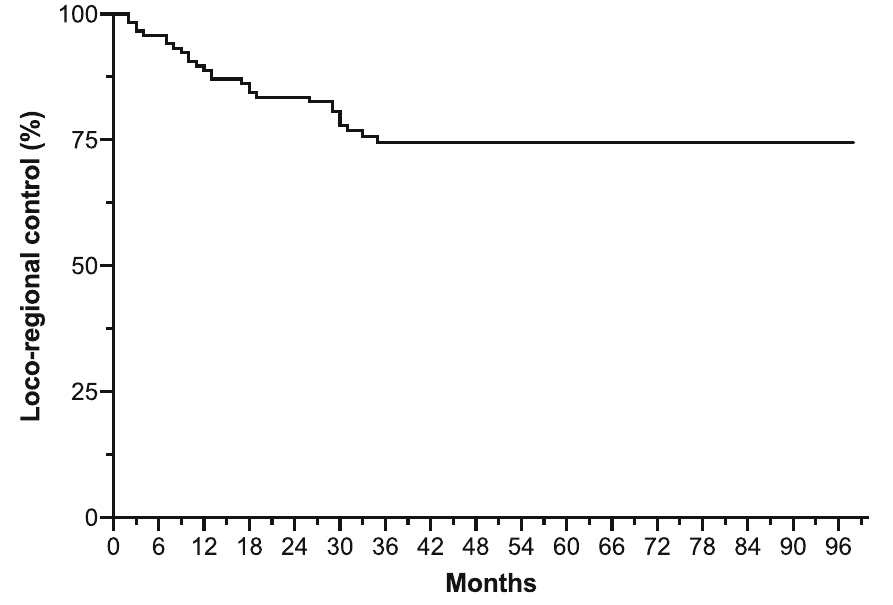
Fig. 1 Loco-regional control (Kaplan-Meyer